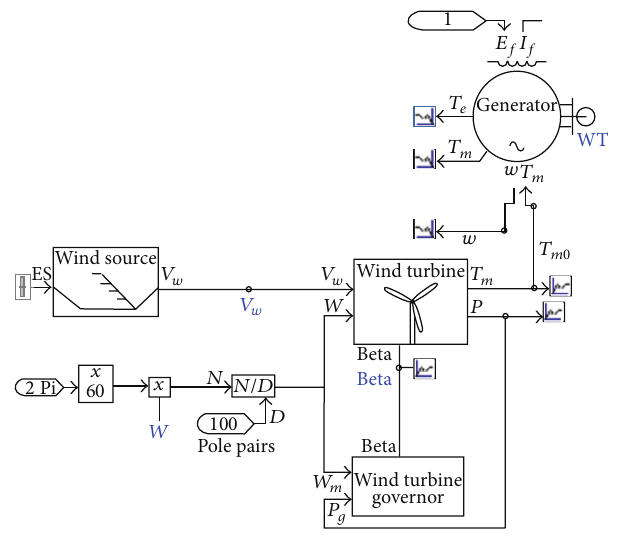
Figure 2: Wind turbine model in PSCAD [3].